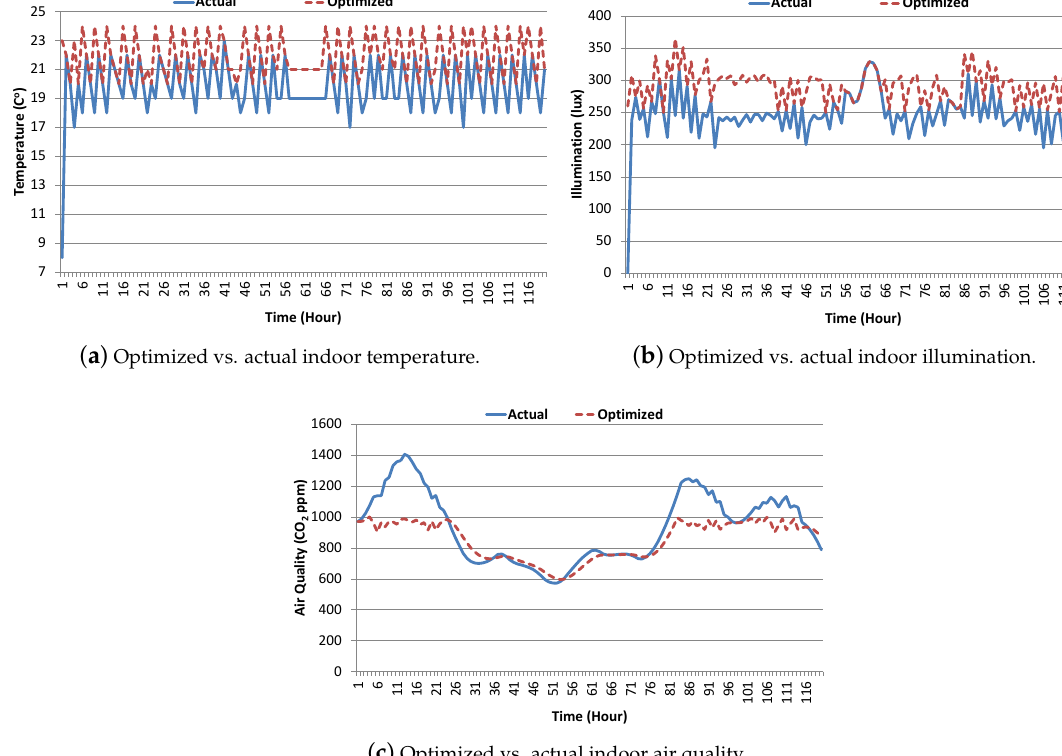
Figure 7. Optimized vs. actual indoor parameters: first five days (120 h) of